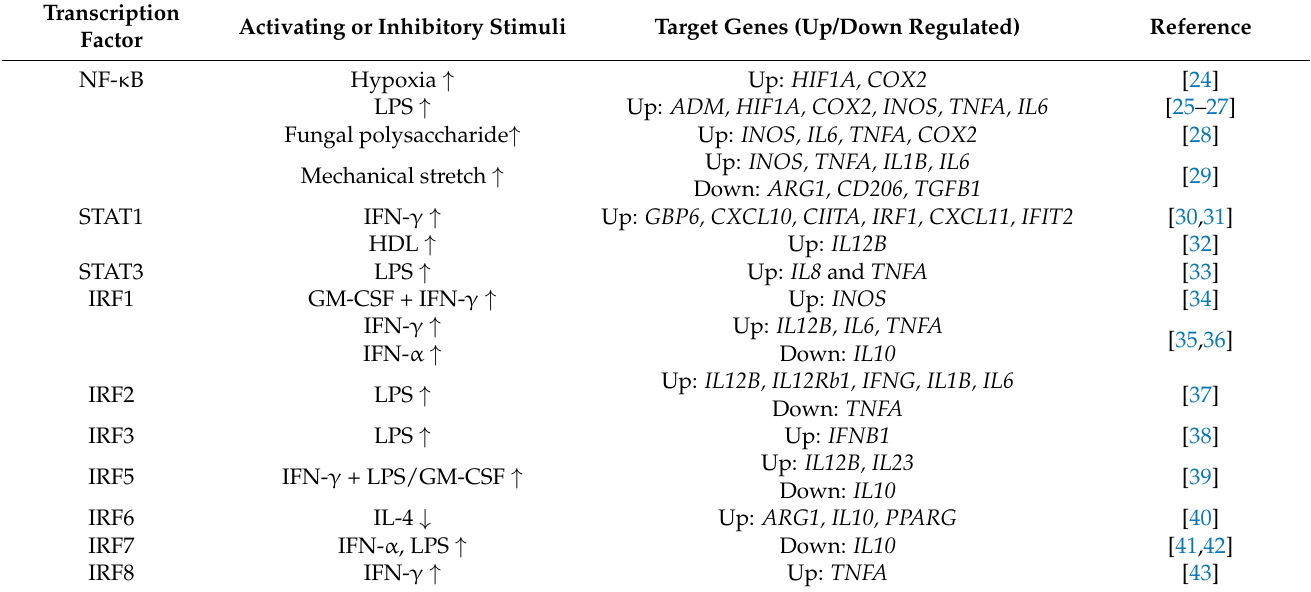
Table 1. Major transcription factors involved in proinflammatory macrophage